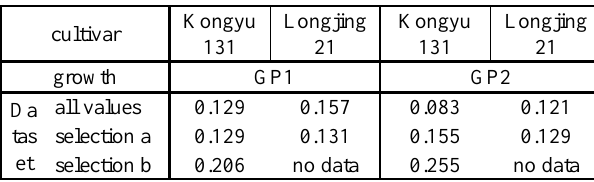
Table 2. Mean plant heights [m] derived from CSMs according to cultivar and GP for all data and selected datasets a and b .